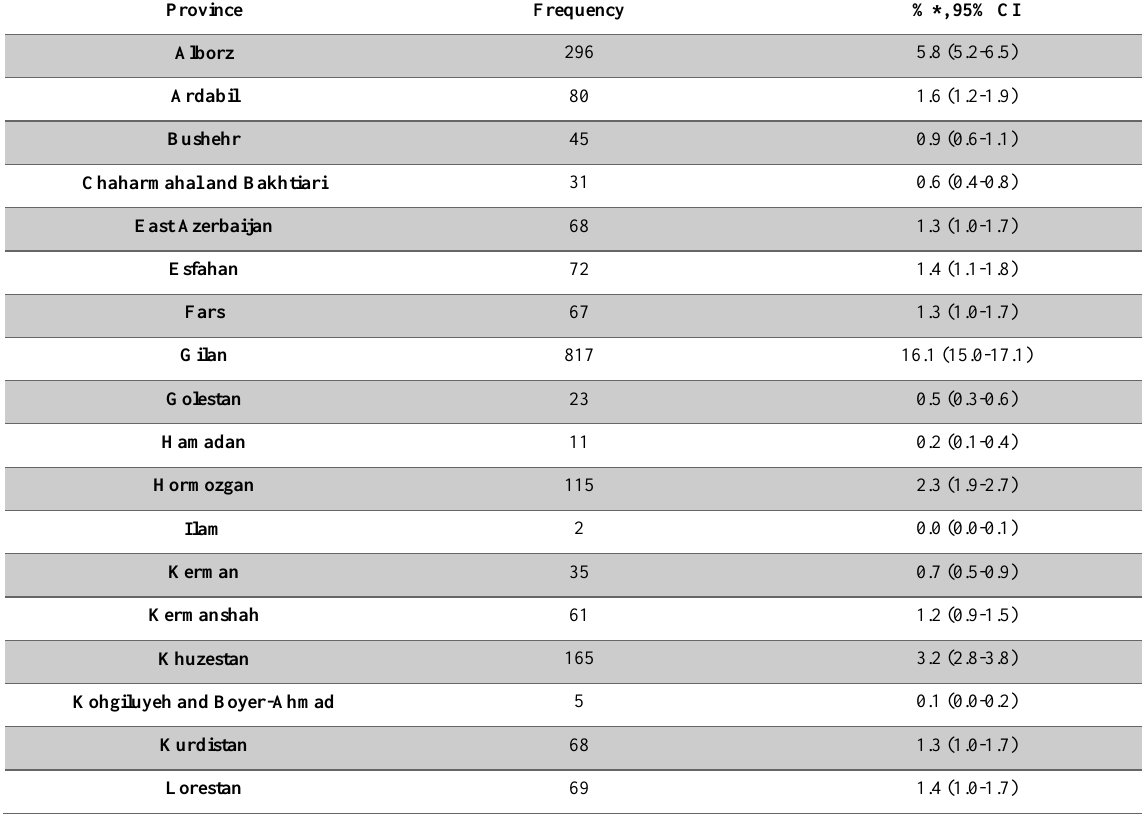
Table 3. The frequency and percentage of HPV infections of 31 Iranian provinces among HPV DNA